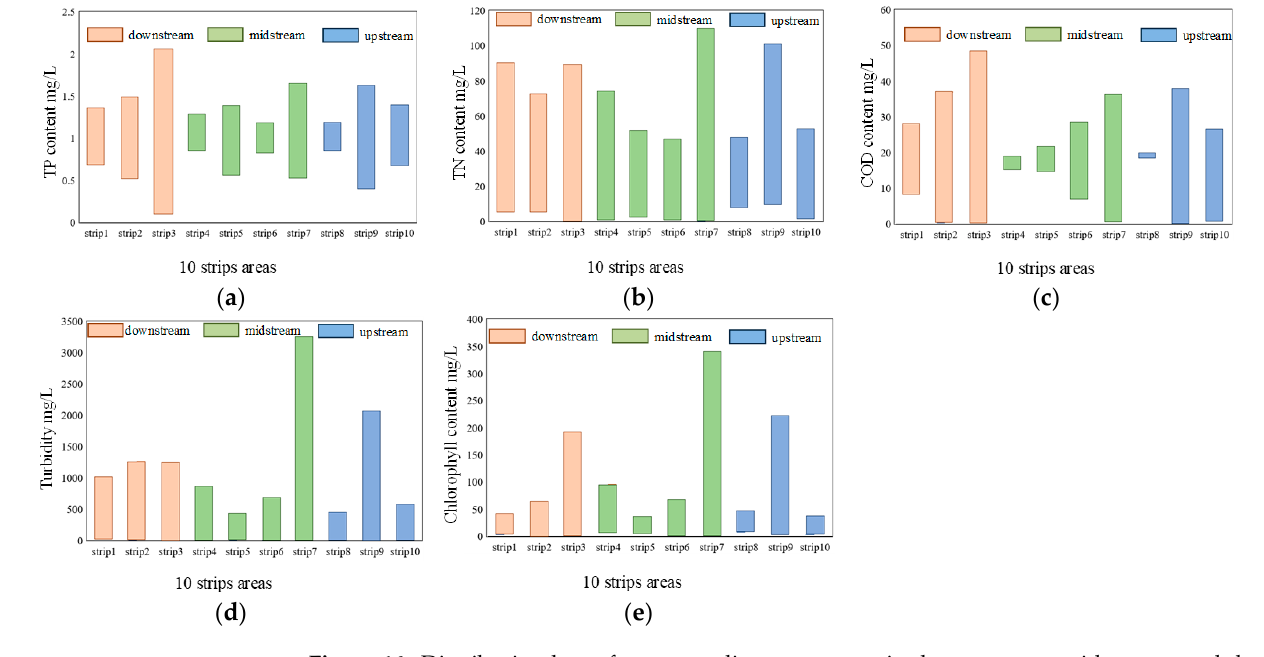
Figure 16. Distribution law of water quality parameters in the upstream, midstream, and down- stream of Lingnan Avenue River. ( a ) distribution law the total phosphorus; ( b ) distribution law the total nitrogen; ( c ) distribution law the COD; ( d ) distribution law the turbidity; ( e ) distribution law the Chlorophyll.